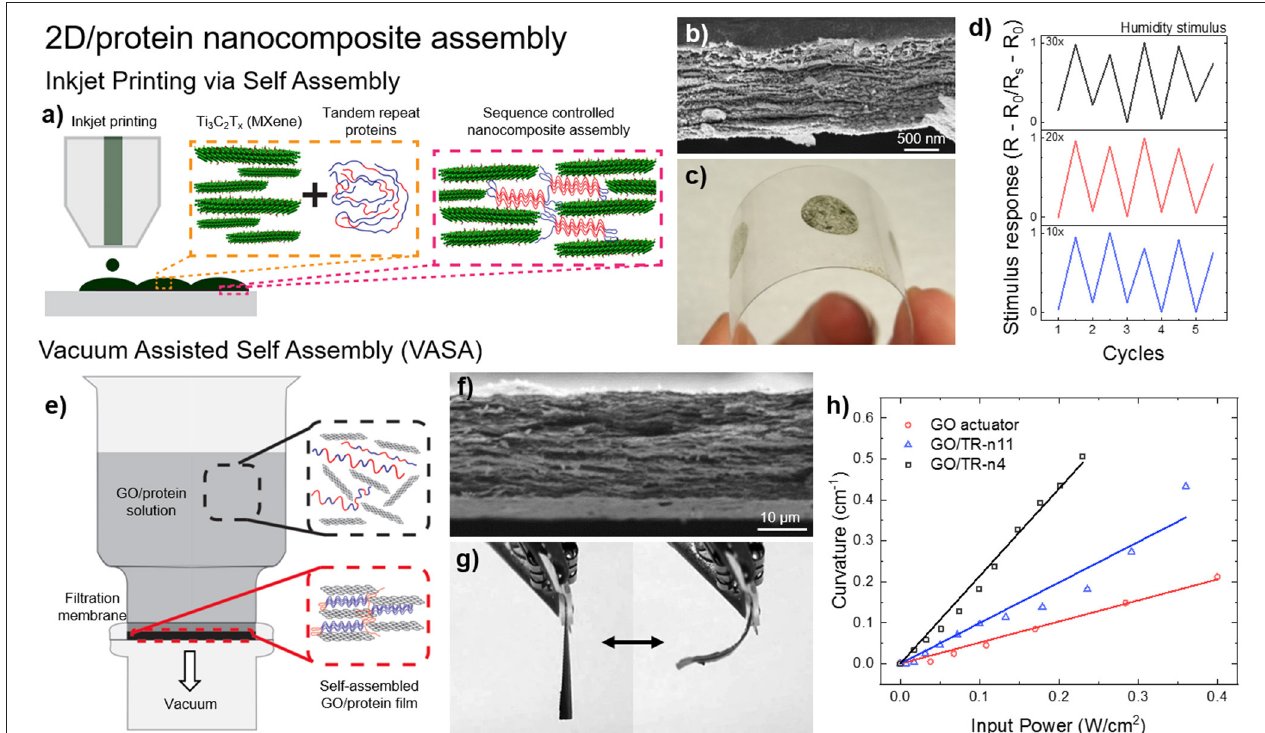
FIGURE 8 | Protein-based 2d-layered nanocomposites. (a) Inkjet printing self-assembly of (b) nanostructured, (c) flexible MXene-SRT protein electrodes and their (d) electrical response to environmental humidity. Reproduced with permission (Vural et al., 2018). Copyright 2018 Wiley. (e) Vacuum assisted self-assembly (VASA) of (f) graphene oxide (GO) and SRT proteins for the fabrication of (g) programmable bimorph thermal actuators with (h) high efficiency. Reproduced with permission ( Vural et al., 2017). Copyright 2017